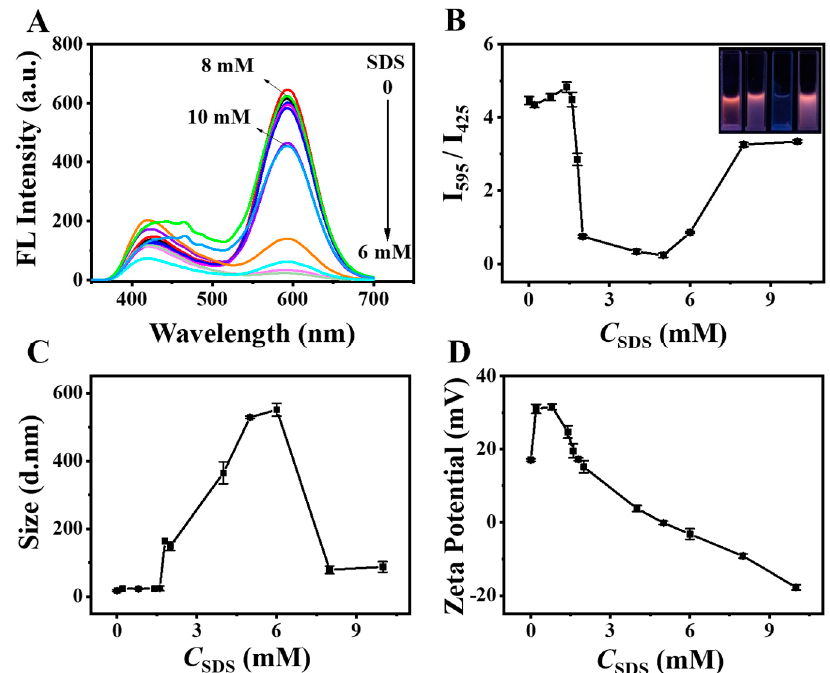
Figure 7. ( A ) Fluorescence emission spectra of DE-Au NC solution upon adding SDS with various concentrations. ( B ) Plots of (I 595 /I 430 ) versus the SDS concentration. Inset images were the fluorescence images of DE-Au NC solution after adding SDS (from left to right: 0, 1.6, 5, 8 mM SDS, respectively) under 310 nm UV light irradiation. Hydrodynamic diameter ( C ) and zeta potential ( D ) of DE-Au NCs upon adding SDS with various concentrations.